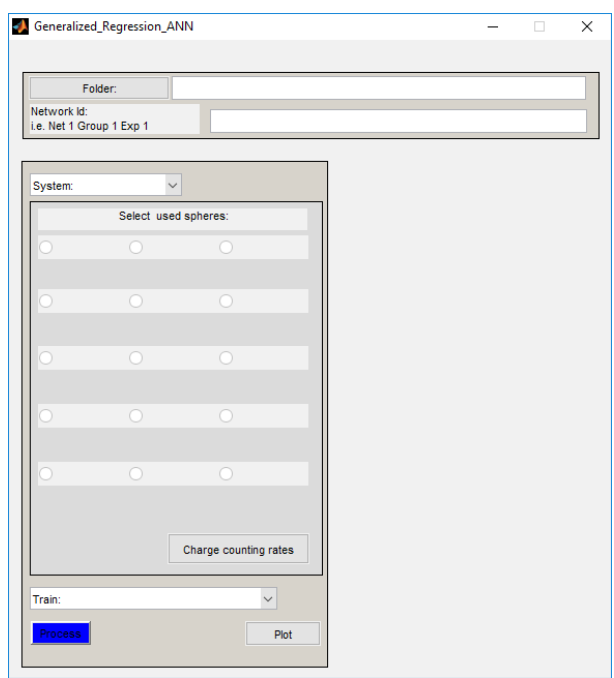
Figure 7. Main window of the Synapse unfolding code